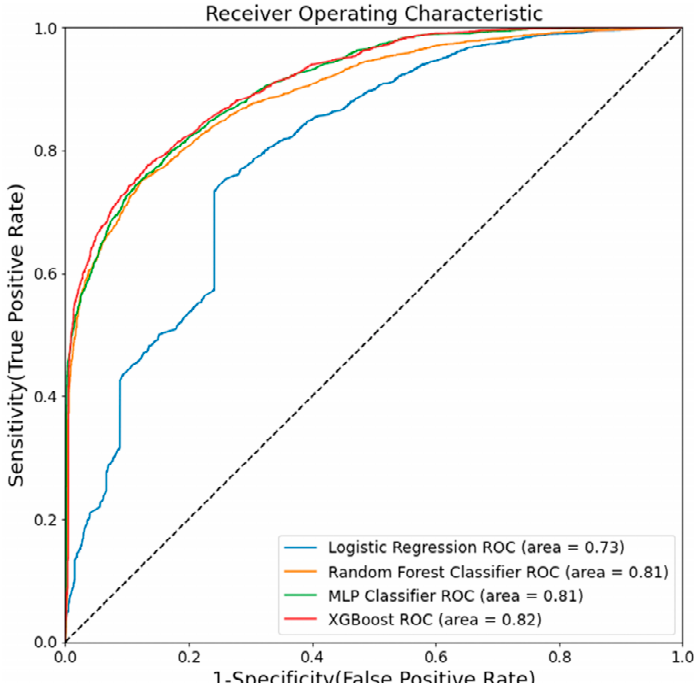
Figure 2. Area under the curve (AUC) for five machine learning methods. AUC measures the entire two-dimensional area underneath the entire ROC curve. Table 3. Elements of the confusion metric for evaluating classification models’ performance assess- ments for four machine learning models. Model